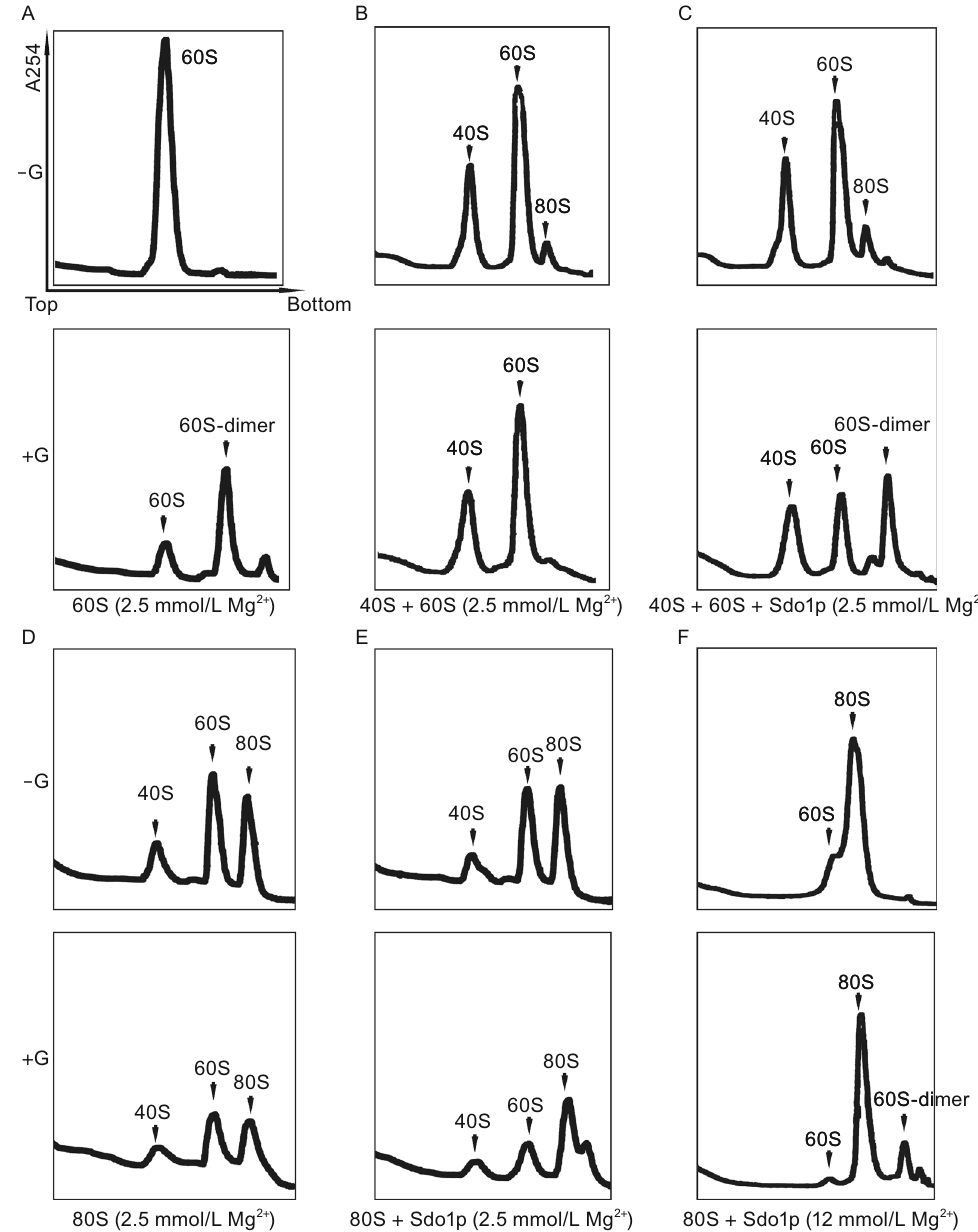
Figure 2. Sdo1p only speci fi cally induces 60S dimerization but not 40S or 80S ribosome. (A) Sdo1p induces the formation of dimers of 60S subunits. (B) A mixture of the 40S and 60S subunits in dissociating condition (2.5 mmol/L Mg 2+ ), in the absence ( − G, top panel) or presence (+G, bottom panel) of 0.1% glutaraldehyde, were subjected to SDGC, indicating that glutaraldehyde alone has no effect on dimer formation. (C) Same as (B), but with 20-fold excess of Sdo1p supplied. (D) 80S ribosomes in dissociating condition, showingapartialdissociationof80Sinto40Sand60Ssubunits.(E)Sameas(D),butwith20-foldexcessofSdo1psuppliedindicatedthat Sdo1p do not induce 40S and 80S ribosome dimerization but only 60S. (F) 80S ribosomes in associating condition (12 mmol/L Mg 2+ ), treated with Sdo1p in the absence or presence of glutaraldehyde also showed Sdo1p do not induce 80S ribosome